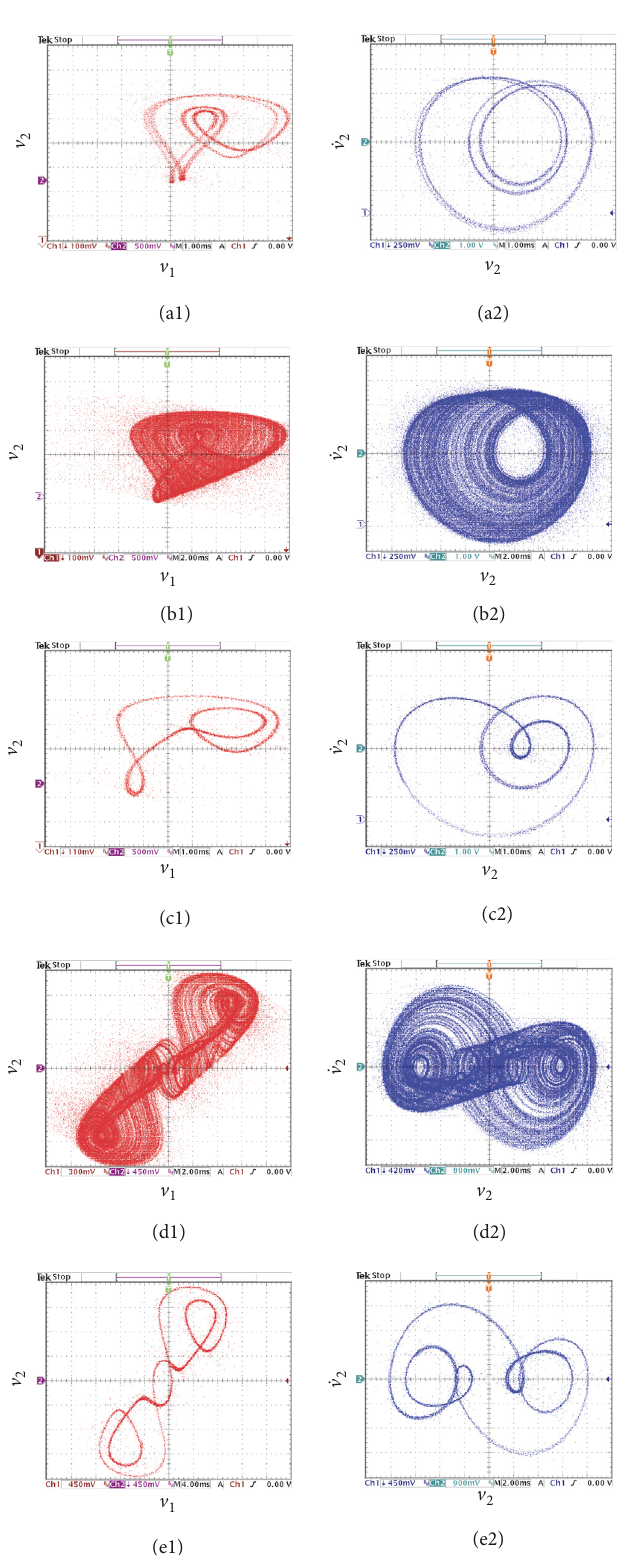
Figure 15: Phase portraits experimentally measured by breadboard circuit for different values of precision adjustable resistor R 3 . (a) R 3 = 475 Ω . (b) R Ω . (c) R Ω . (d) R Ω . (e) R Ω 3 = 531 3 = 614 3 = 1.06 k 3 = 1.27 k